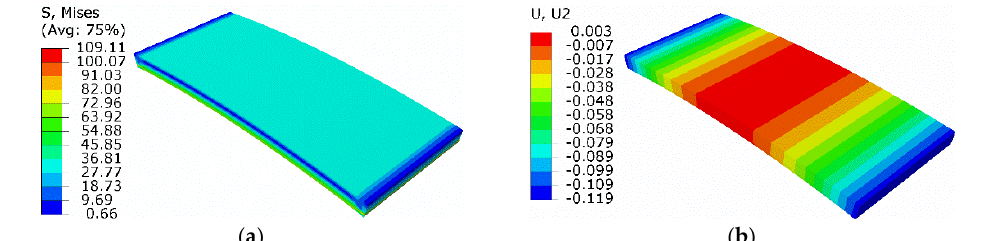
Figure 11. Results of simulation based on equivalent thermal strain approach: ( a ) equivalent stress; ( b ) normal displacement. ( b ) normal